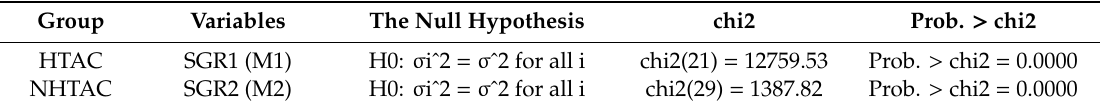
Table 6. Modified Wald test for groupwise heteroskedasticity.